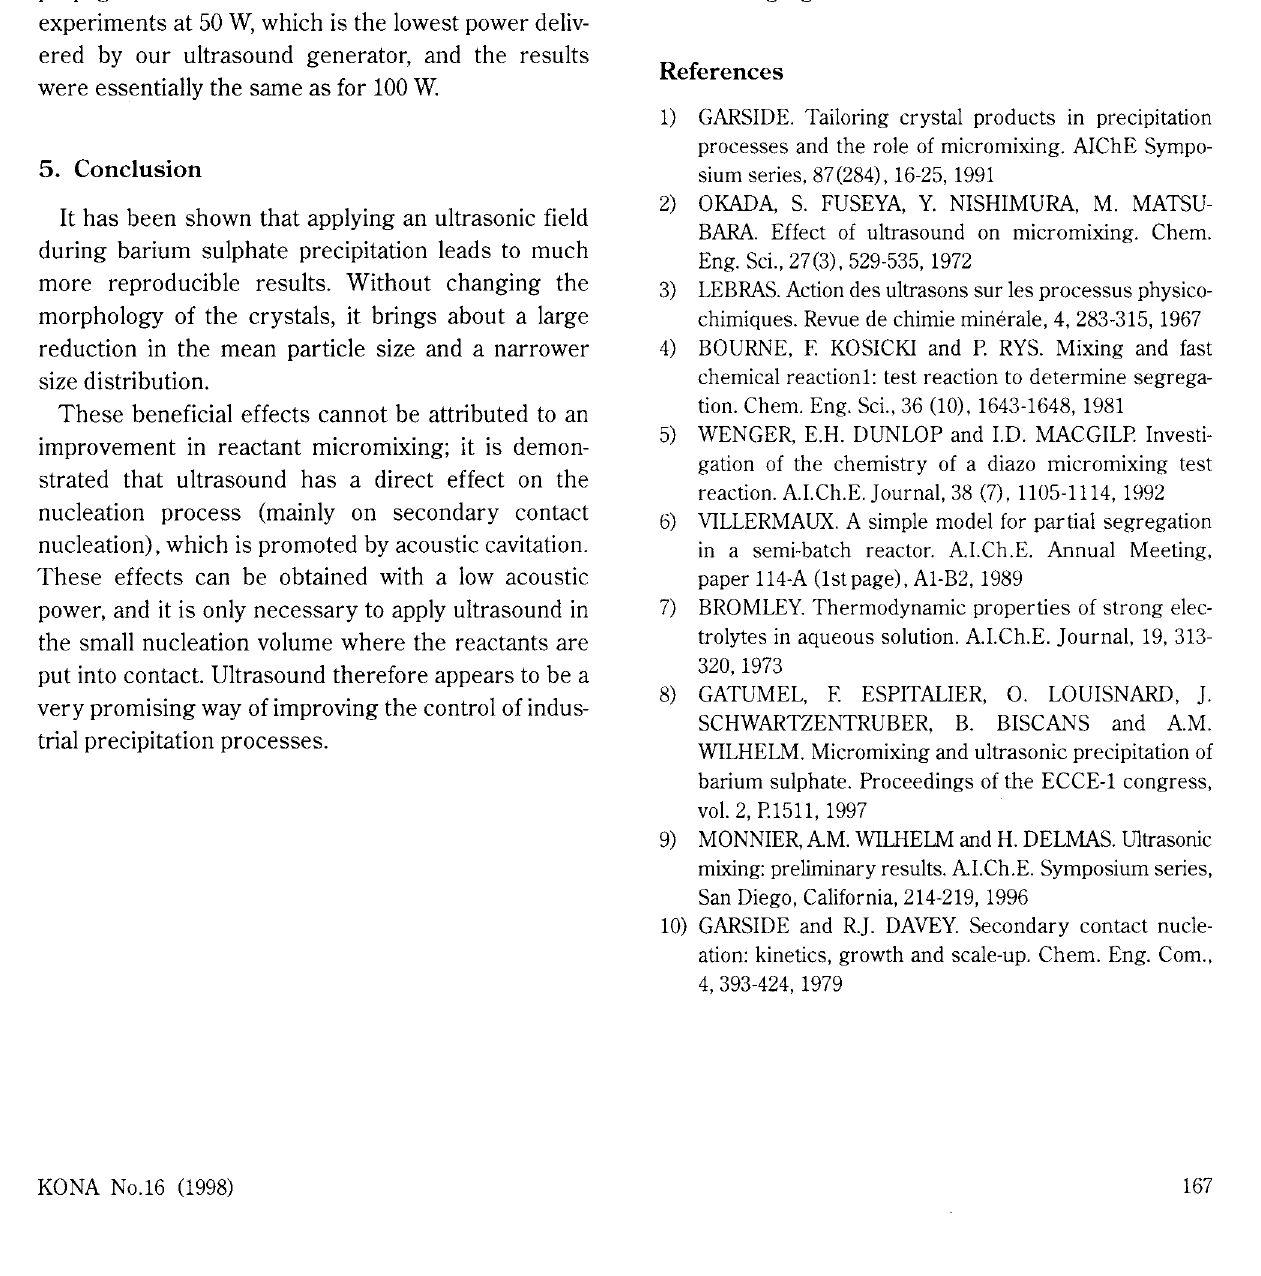
Fig, 11 Effects of ultrasound power and location on mean crystal size and number of